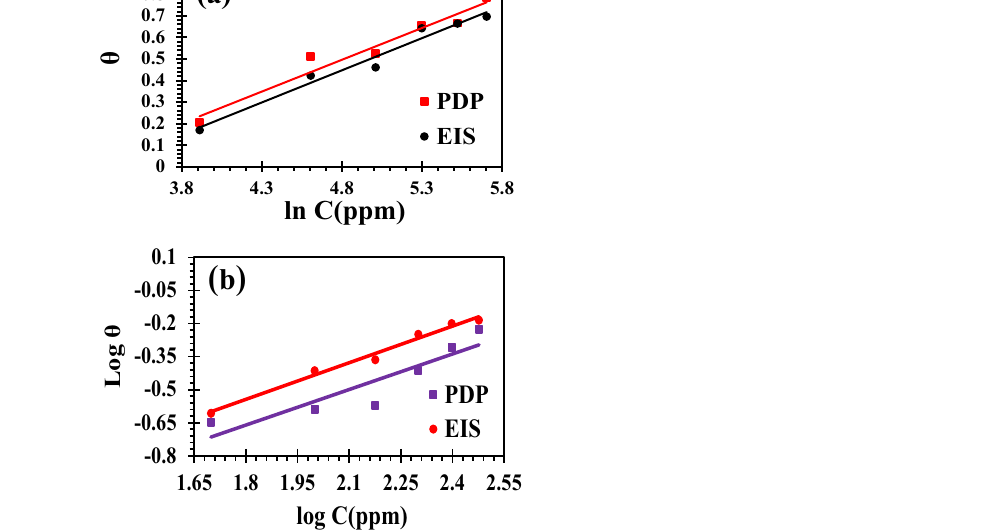
Figure 12. Adsorption isotherms based on PDP and EIS measurements for Al in 0.1 M NaOH containing different concentrations of Cefx and Cefz at 293 K; ( a ) Temkin isotherm for Cefx and ( b ) Freundlich isotherm for